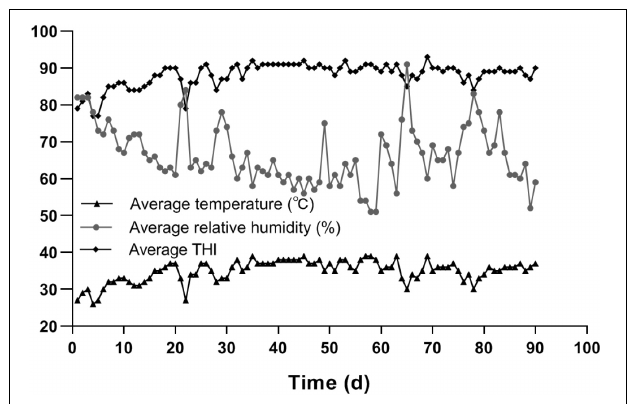
FIGURE 1 | The average temperature, average relative humidity, and THI during the trial period.